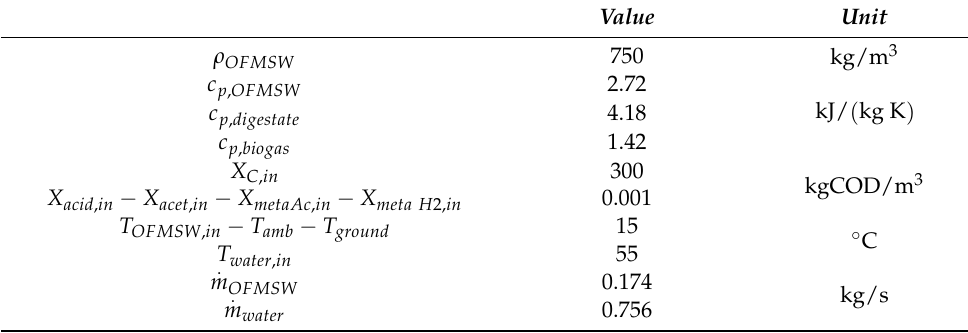
Table 3. Inlet parameters of the